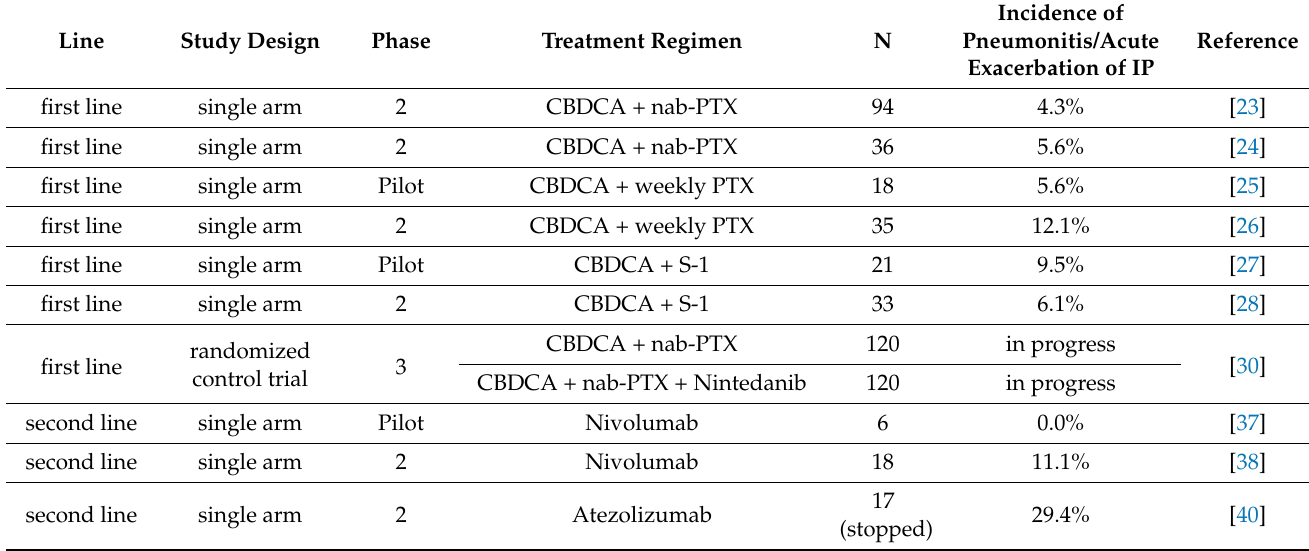
Table 2. Key prospective studies in NSCLC with comorbid